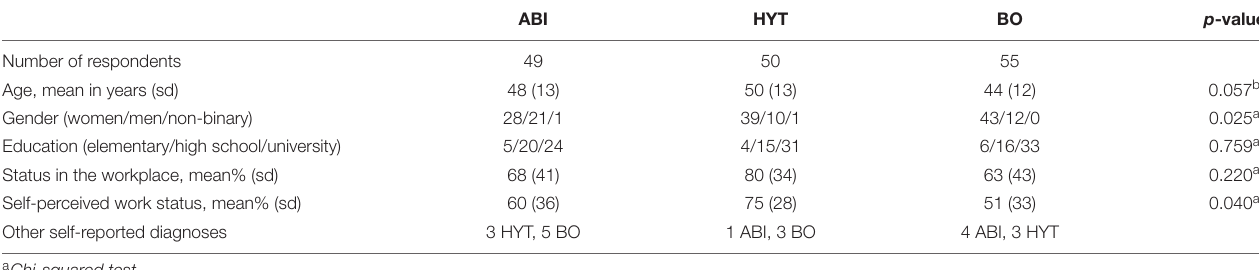
TABLE 1 | Number of respondents (total 154), frequency, means, standard deviation (sd), statistical comparison between the ABI (acquired brain injury), HYT (hypothyroidism), and the BO (burn-out syndrome) ( p -value) groups. ABI HYT BO